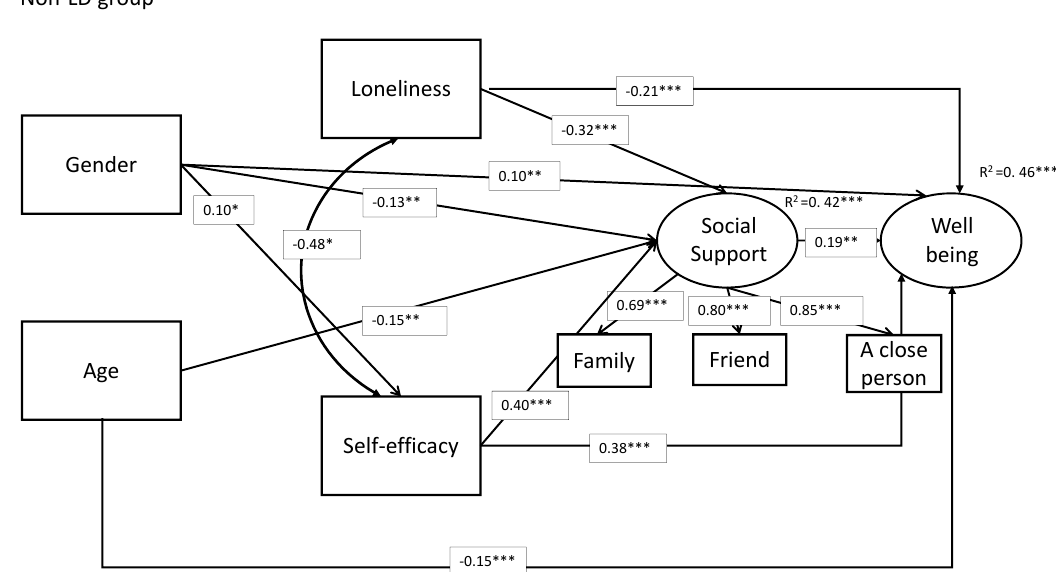
Figure 2. The model within a structural equation framework for non-LD group. *** p < 0.001; ** p < 0.01; * p < 0.05.